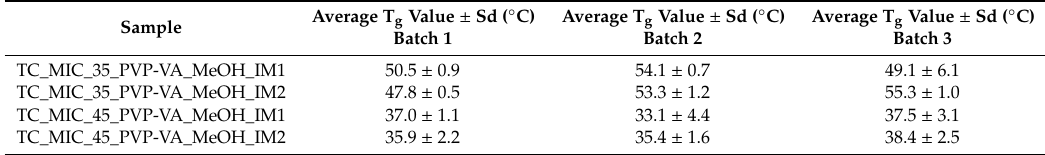
Table 4. Repeatability of the surface coating procedure. Average T g values ± sd for MIC_PVP-VA surface coated tablets, using the intermittent spraying procedures IM1 (20 s–20 s) and IM 2 (20 s–40 s).